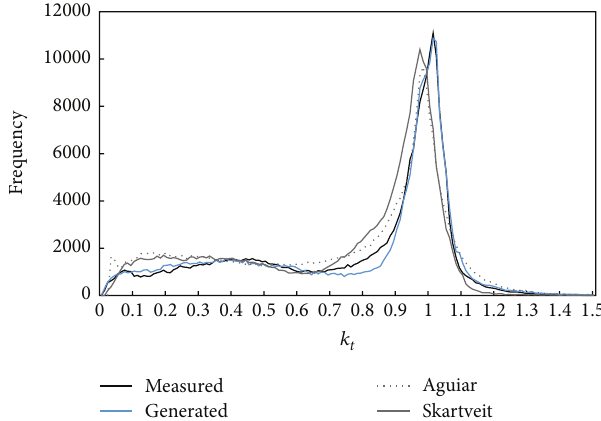
Figure 8: Frequency distributions of measured global irradiance for Lindenberg (Germany, 2005) against values generated by different algorithms. Mid values are slightly overestimated, and high values are underestimated by the existing models (grey dotted), resulting in RMSE of 0.530% for Aguiar and 0.684% for Skartveit. The modelling quality of the new method (blue) does not overestimate mid irradiance values and shows only little underestimation of high irradiance values. The new RMSE can be reduced to 0.210%.